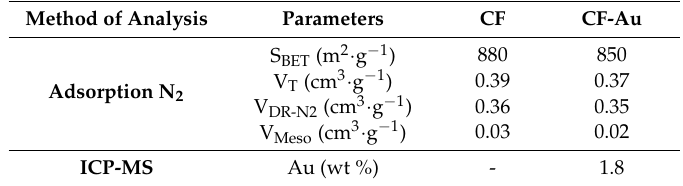
Table 1. BET surface area, total pore volume (V T ), micropore volume (V DR-N2 ), mesopore volume (V Meso ) and gold content in the support (carbon foam (CF)) and impregnated support